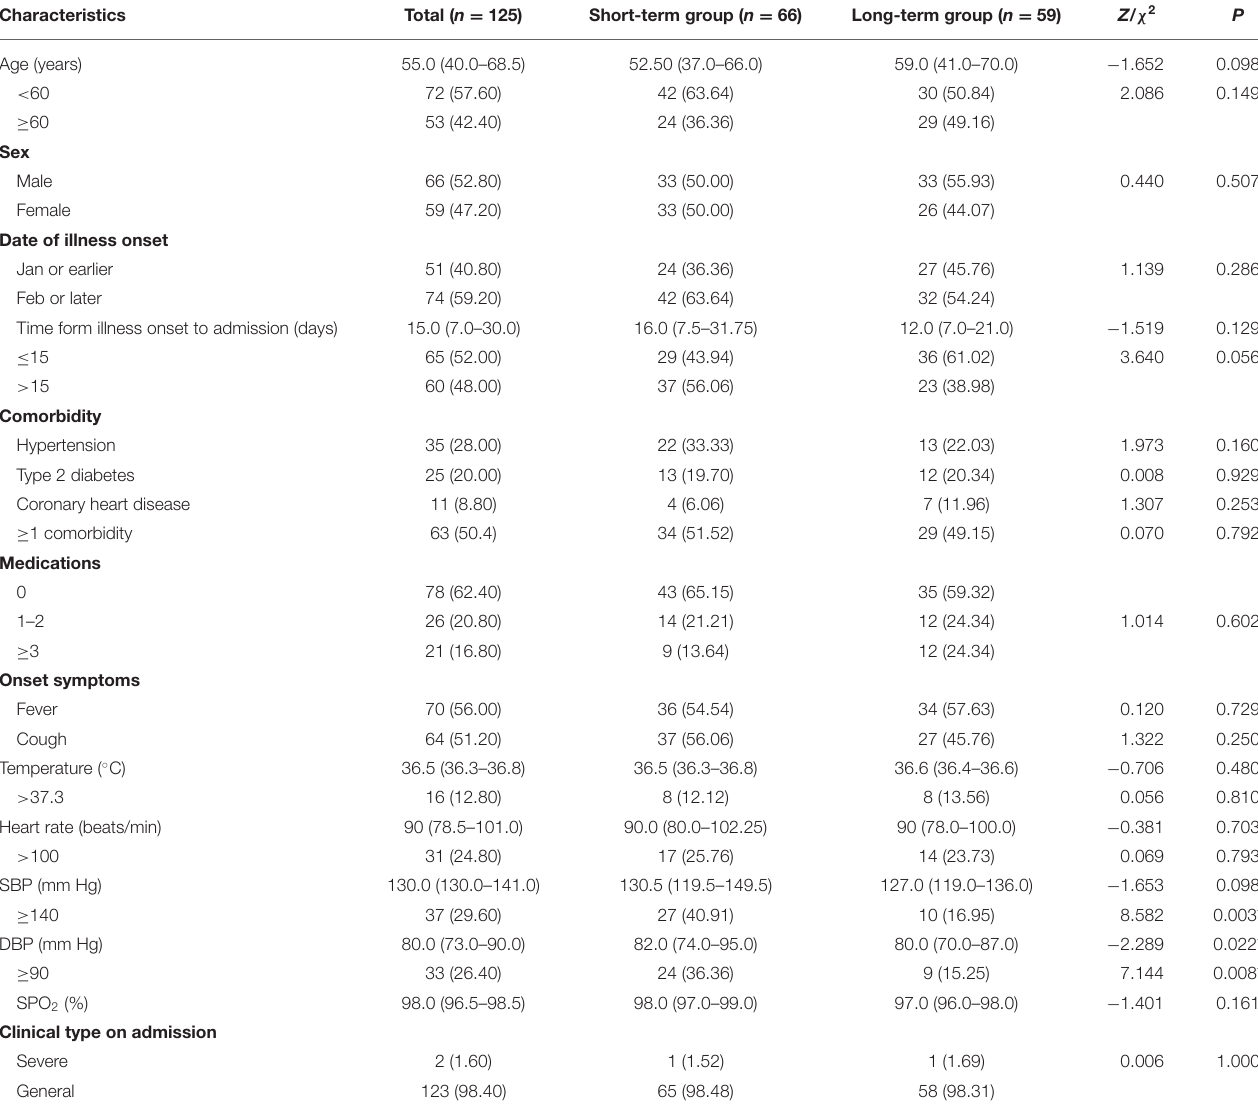
TABLE 1 | Comparisons of demographic and clinical characteristics of 125 patients with COVID-19 between the two groups.